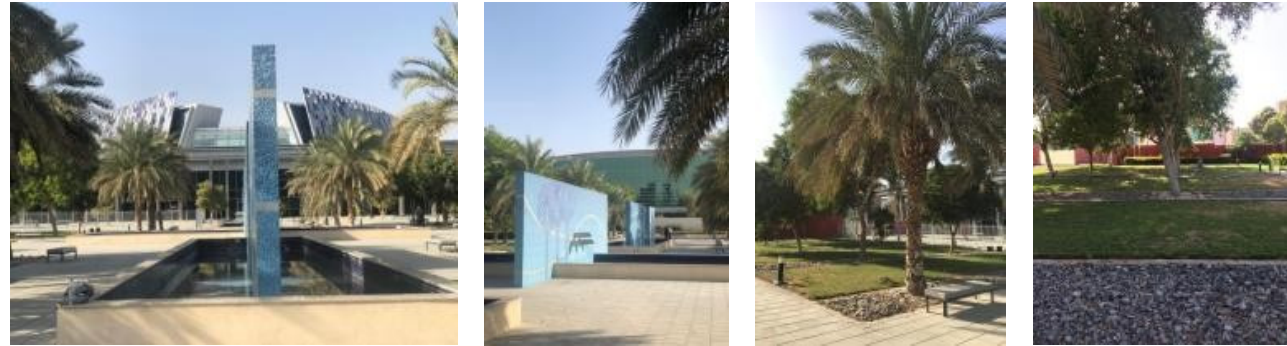
Figure 3. ( a ) Surrounding building footprint analysis, ( b ) site analysis map.